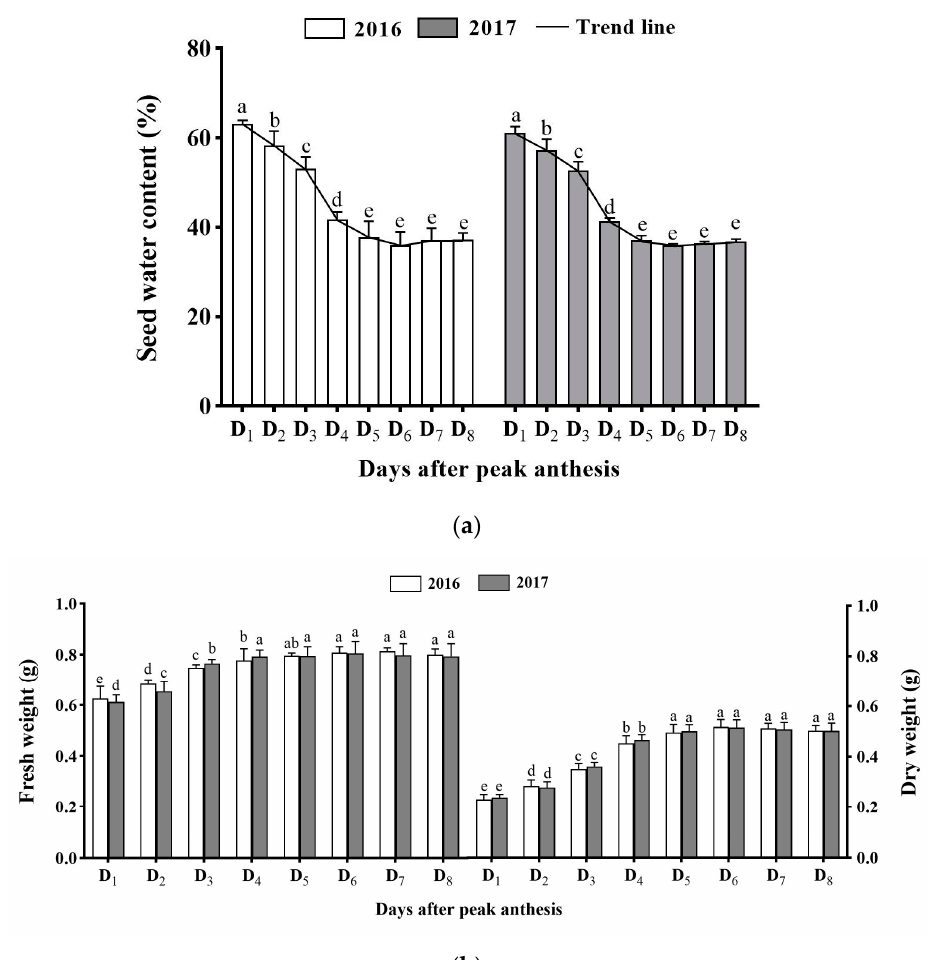
Figure 2. The seed water content ( a ) and fresh and dry weights of seeds ( b ) (mean ± standard error, n = 4) of K. melanthera as influenced by days after peak anthesis of seeds during the trial years of 2016–2017. For each day after peak anthesis, values with the different letter are significantly different based on Bonferroni’s t -test ( p < 0.05). The standard error of mean is shown by a vertical bar.